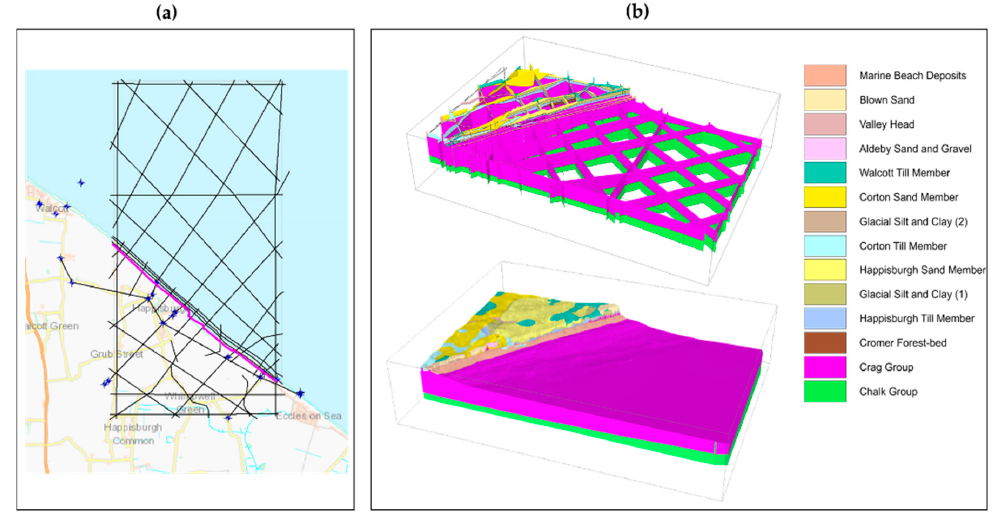
Figure 8. Happisburgh 3D lithological model; ( a ) distribution of boreholes (blue circles) and cross- sections (black lines) used to construct the model, master coastal cross-section is highlighted in magenta; ( b ) upper panel shows all the cross sections with its interpreted geology and bottom panel shows the interpolated 3D lithological model.